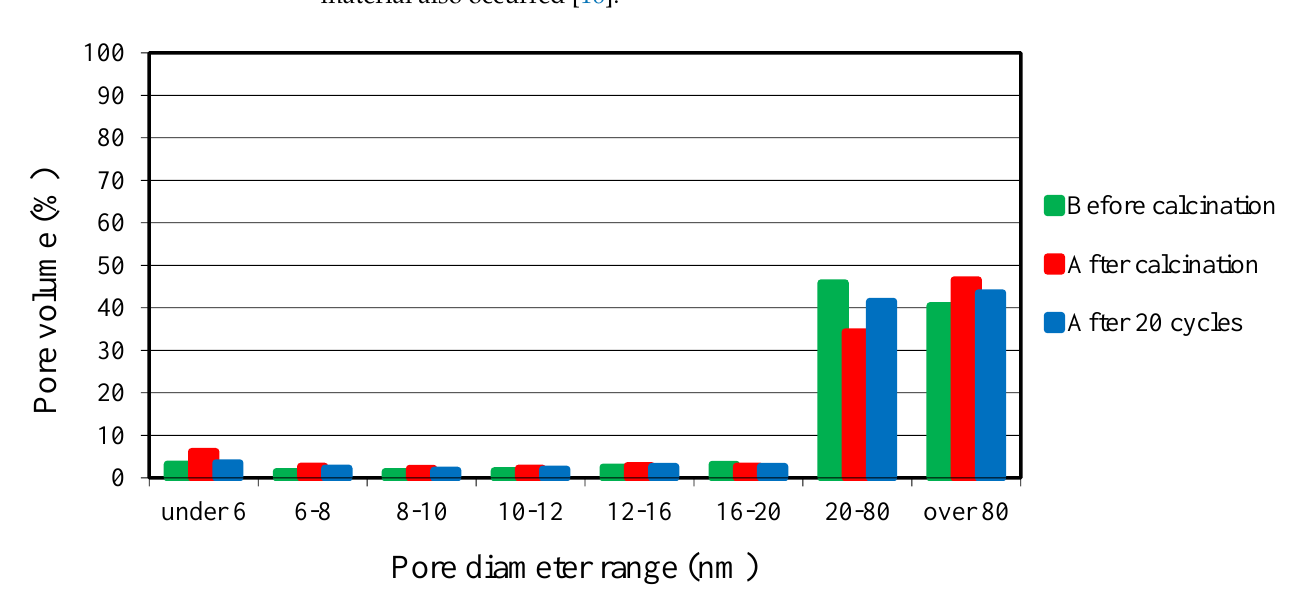
Figure 7. A comparison of Tetín limestone pore size distribution before calcination, after calcination, and after 20 cycles.